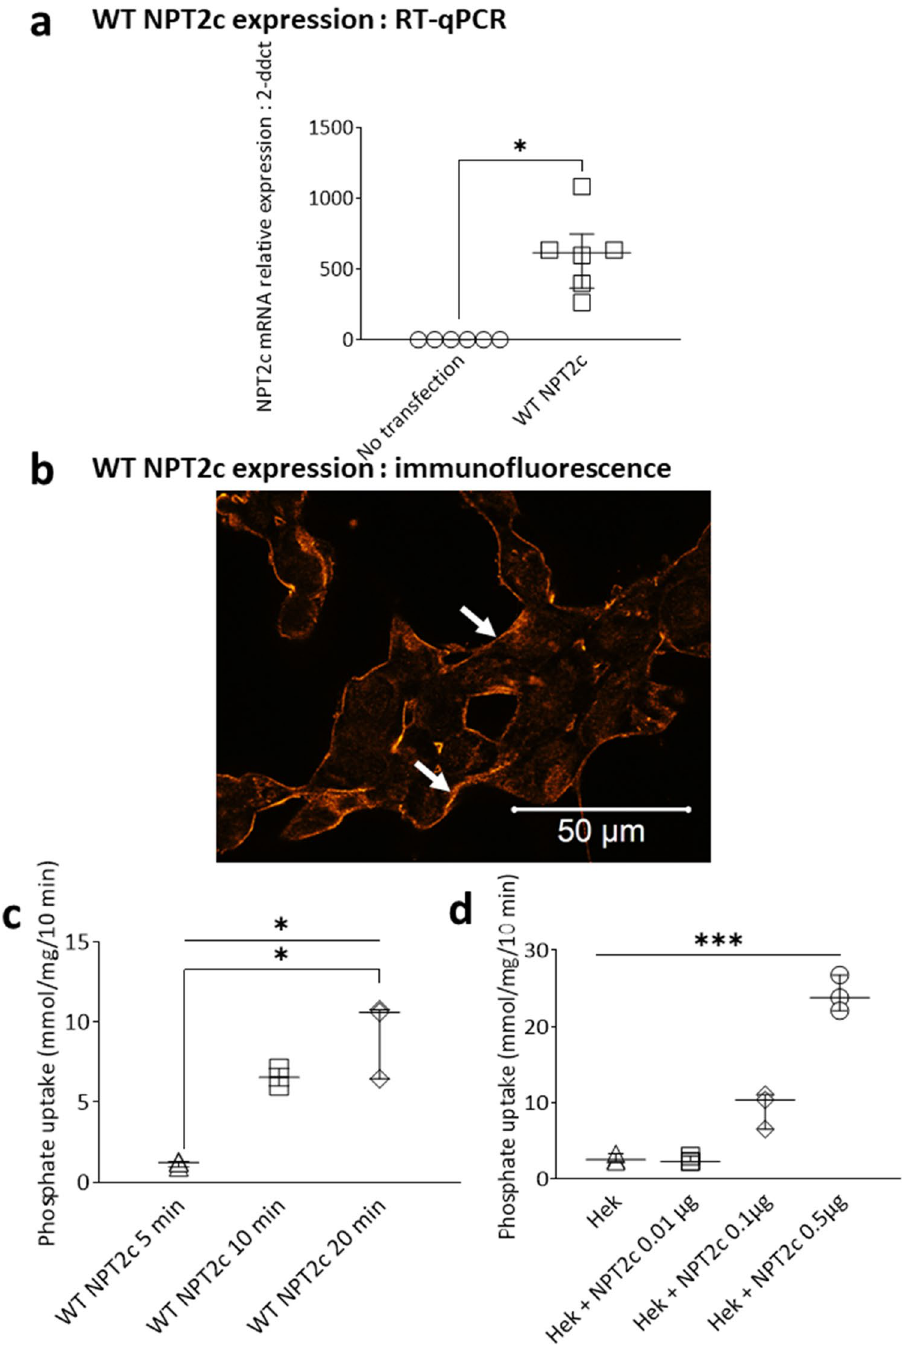
Figure 1. Expression of wild-type NPT2c in HEK cells. ( a ) NPT2c and GAPDH mRNA expression in HEK cells not transfected and transfected with wild-type NPT2c plasmid (0.5 μg of DNA and 1 μl of lipofectamine 2000 per well). Quantitative data represent 3 independent experiments. Statistical analysis was performed using a non-parametric Mann–Whitney test. *p < 0.05. ( b ) NPT2c immunofluorescence 48 h after transfection in HEK cells (0.5 μg of DNA and 1 μl of lipofectamine 2000 per well) localizes mainly at the plasmic membrane. ( c ) Phosphate accumulation with time in HEK cells transfected with WT NPT2c plasmid (0.5 μg of DNA and 1 μl of lipofectamine 2000 per well). Phosphate accumulation increases with time. Quantitative data represent 3 independent experiments. Statistical analysis was performed using a non-parametric Kruskall–Wallis test followed by Dunn’s multiple comparison post-hoc test. *p < 0.05. Simple line represents Kruskall–Wallis test and zig-zag lines represent Dunn’s multiple comparison post-hoc test. ( d ) Sodium-dependent phosphate uptake measured in HEK cells transfected with various amounts of WT NPT2c plasmid (0.01 μg, 0.1 µg and 0.5 µg per well). The more the amount of plasmid, the greater the phosphate uptake. Quantitative data represent 3 independent experiments. Statistical analysis was performed using a non-parametric Kruskall–Wallis test followed by Dunn’s multiple comparison post-hoc test. ***p < 0.001. Simple line represents Kruskall–Wallis